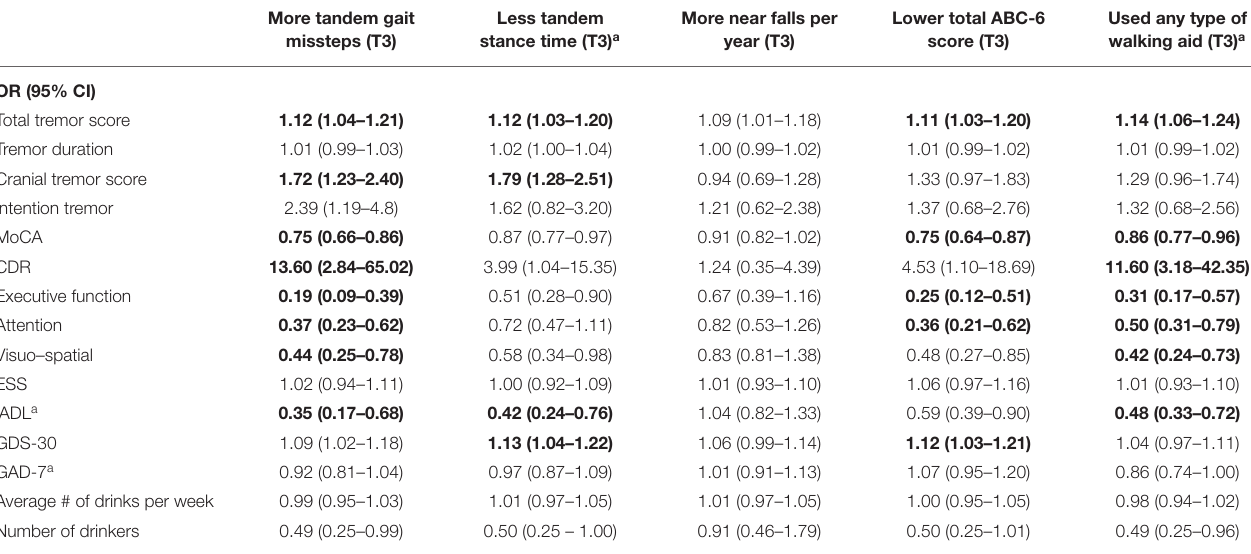
TABLE 3A | Unadjusted logistic regression models: Baseline characteristics as predictors of T3 gait and balance